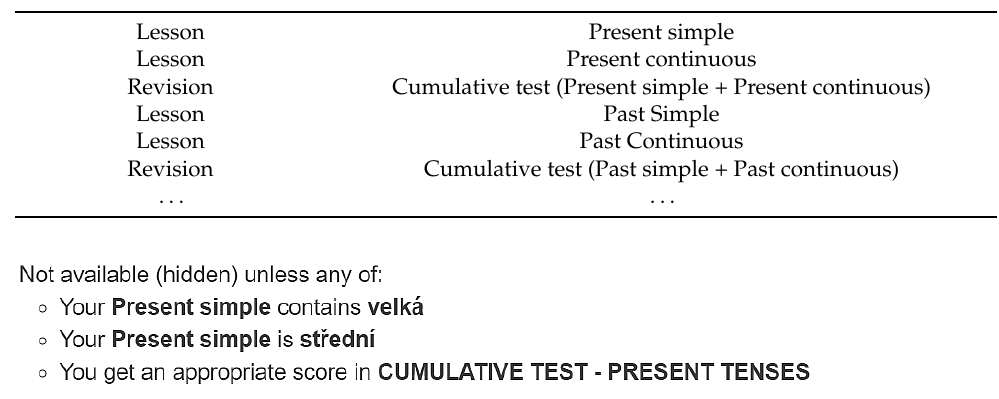
Table 2. A general structure of the e-course.